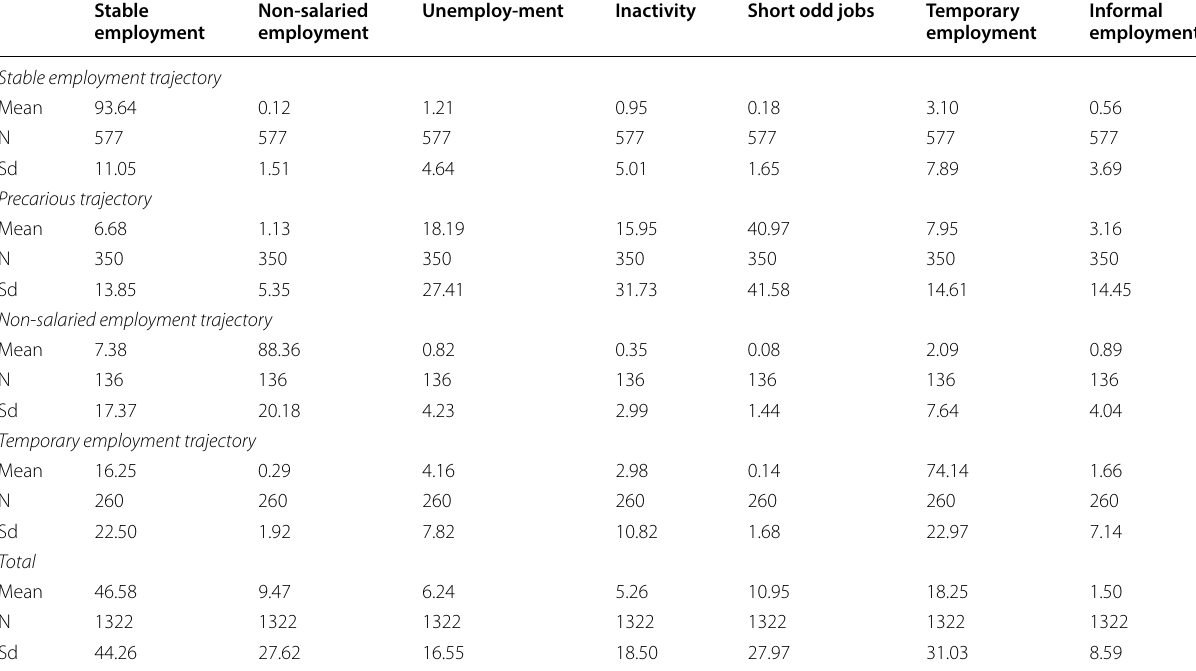
Source: Calculated by authors based on the 2012 Catalan Youth Survey data